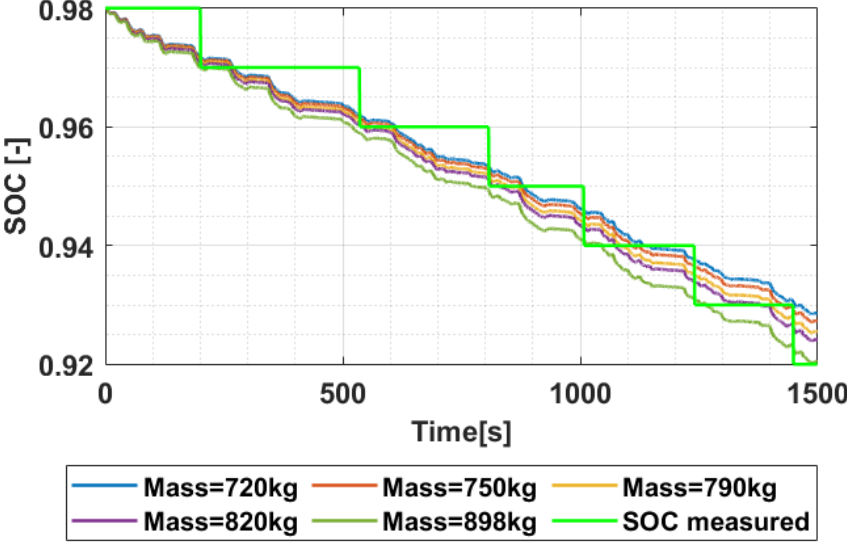
Figure 14. Comparison of the battery state of charge trajectories estimated by the model considering different vehicle masses with respect to the experimental battery state of charge of DM15.